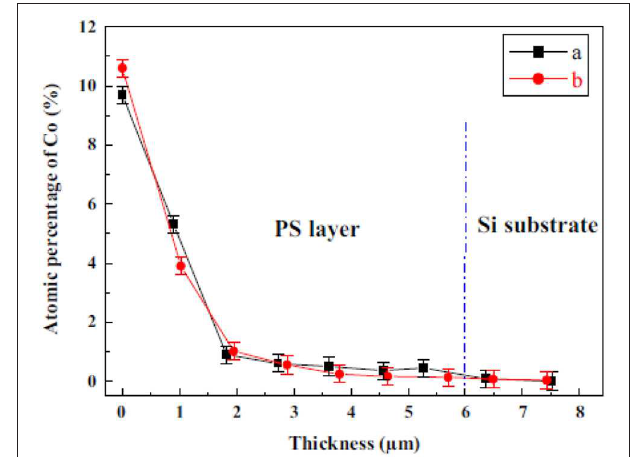
FIGURE 1 | Cross-sectional SEM image of hydrophobic porous silicon filled with Pt. Fukami et al. [46], Elsevier by permission.